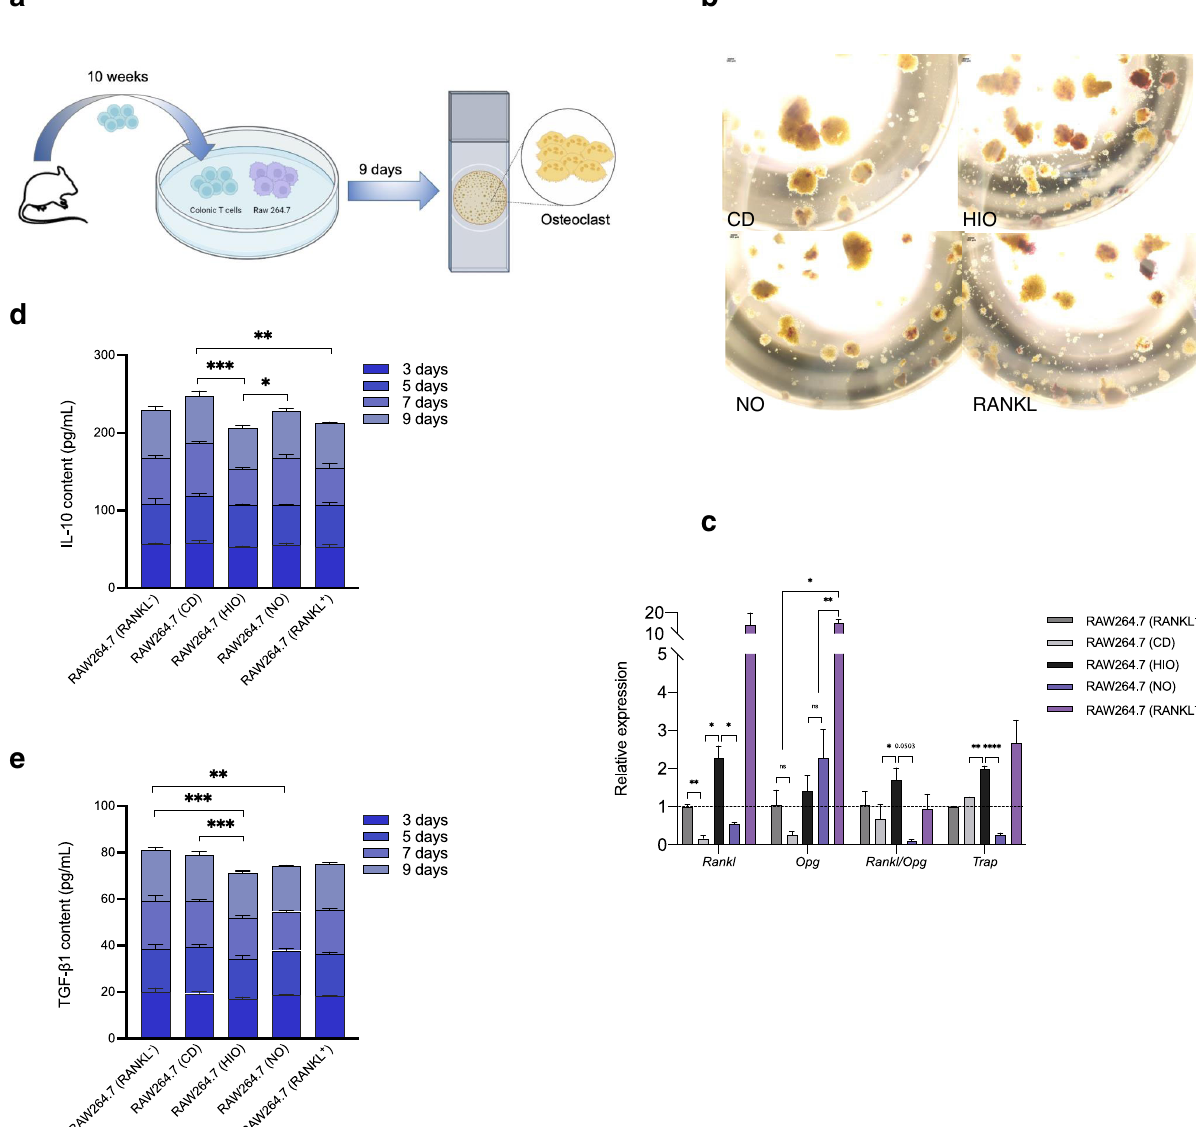
Fig. 5 T cells inhibit differentiation of RAW 264.7 macrophages ex vivo. a Study design. T cells obtained from CD, HIO, and NO were cocultured with RAW264.7 macrophages for 9 days. b TRAP staining. c Total RNA was extracted from the RAW264.7 macrophages, and the relative expression of Rankl , Opg , Rankl / Opg and Trap was determined. d – e Assessment of cytokines of IL-10 and TGF- β levels in cell supernatants. n = 3 per group. Data are presented as means ± SEM. Two-way ANOVA was used to analyze the signi fi cance of